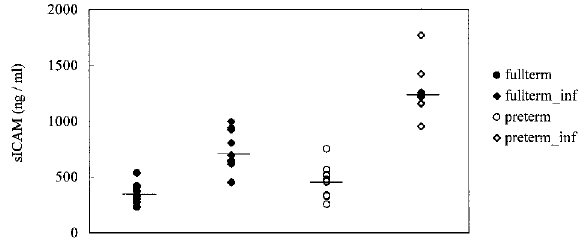
FIG. 1. sICAM-1 values of all groups. Horizontal lines represent the mean values of sICAM-1 of each group, open symbols refer to premature infants, and filled symbols refer to full-term infants.